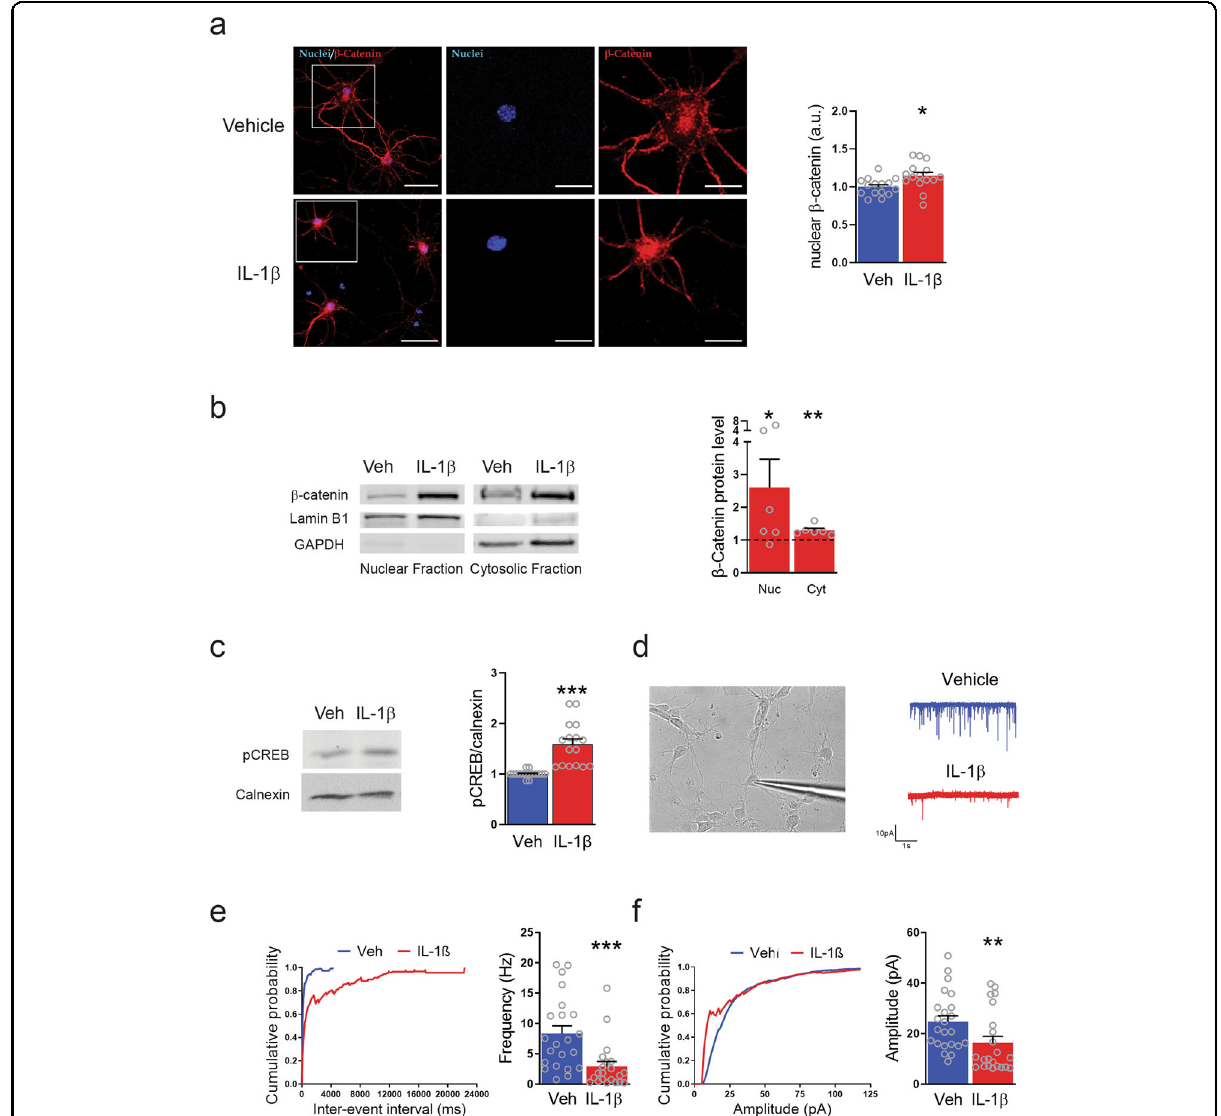
Fig. 4 IL-1 β treatment increases nuclear β -catenin and CREB activation, while it decreases excitatory synaptic strength in cortical neurons. a Representative images (left) and quanti fi cation (right) of nuclear β -catenin signal in primary neurons treated with either vehicle (Veh, blue bar) or IL- 1 β (red bar) for 24 h and stained for β -catenin (red). DAPI-stained nuclei are in blue. Separate channels are shown for the high-magni fi cation images of the boxed regions. Scale bars, 50 and 10 μ m for low and high magni fi cation, respectively. b Representative immunoblots (left) and quanti fi cation (right) of β -catenin levels in nuclear and cytosolic fractions from primary neurons treated as in a . Immunoblotting for Lamin B1 and GAPDH as nuclear and cytosolic markers, respectively, was used to check the purity of the subcellular fractions. The changes in β -catenin levels in nuclear and cytosolic fractions upon treatment with IL-1 β are expressed in percentage of the respective values in vehicle-treated samples. c Quantitative western blotting analysis of CREB phosphorylation in neurons treated with either IL-1 β or vehicle (Veh) for 20 min. Calnexin was used as loading control. d Representative image of patch-clamped neurons (left) and representative traces of mEPSCs (right) recorded in cortical neurons treated with either vehicle (blue trace) or IL-1 β (red trace) for 20 min at 7 DIV. Recordings were performed at 14 DIV. e Cumulative distribution of inter-event intervals (left) and mean (±sem) frequency (right) of mEPSCs. f Cumulative distribution (left) and mean (± sem) amplitude (right) of mEPSCs. Bar graphs show mean ± sem with superimposed individual points obtained from distinct culture dishes prepared from at least n = 3 independent preparations. Veh: n = 23 and IL-1 β : n = 22. * p < 0.05, ** p < 0.01, *** p < 0.001; unpaired two-tailed Student ’ s t test.